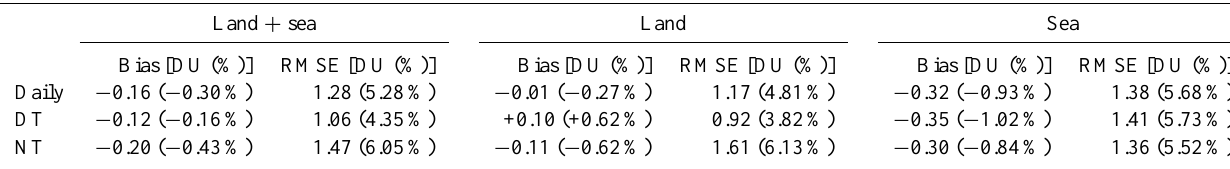
Table 4. Mean biases and RMSEs of MAGEAQ-TIR surface–6km TOC pseudo-observations, with respect to MOCAGE pseudo-reality. Results are reported for all data, land (sea) only, DT (NT) only, and all various combinations. Percent values of biases and RMSEs are reported in parentheses.